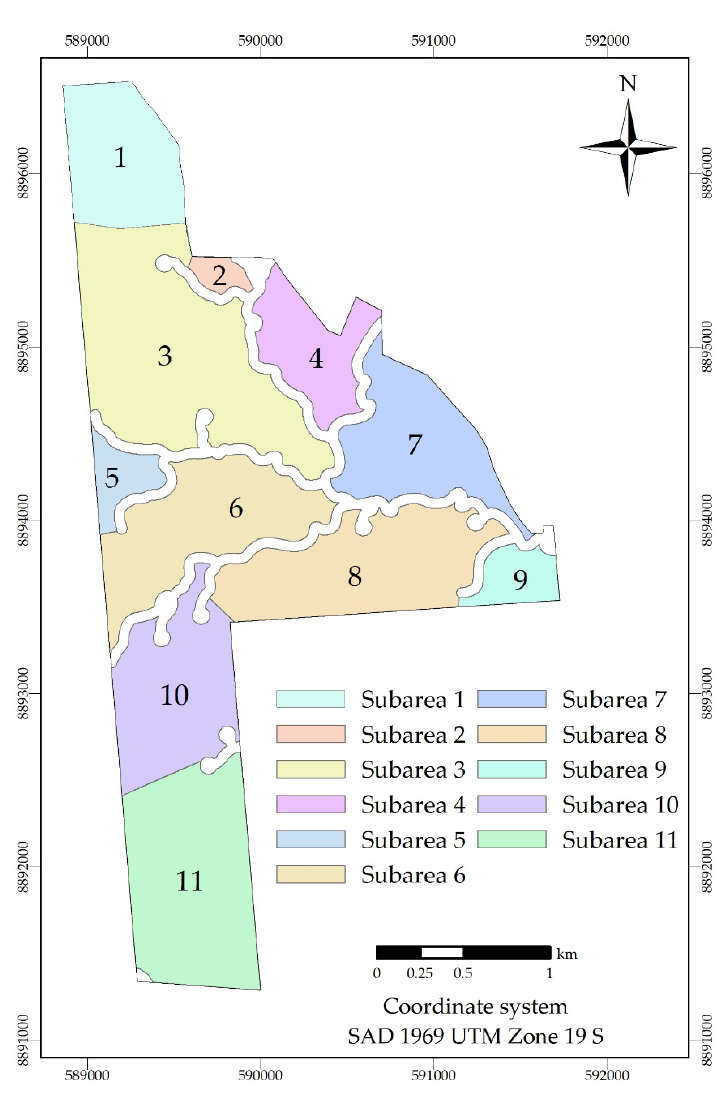
Figure 3. Map showing the formation of subareas.